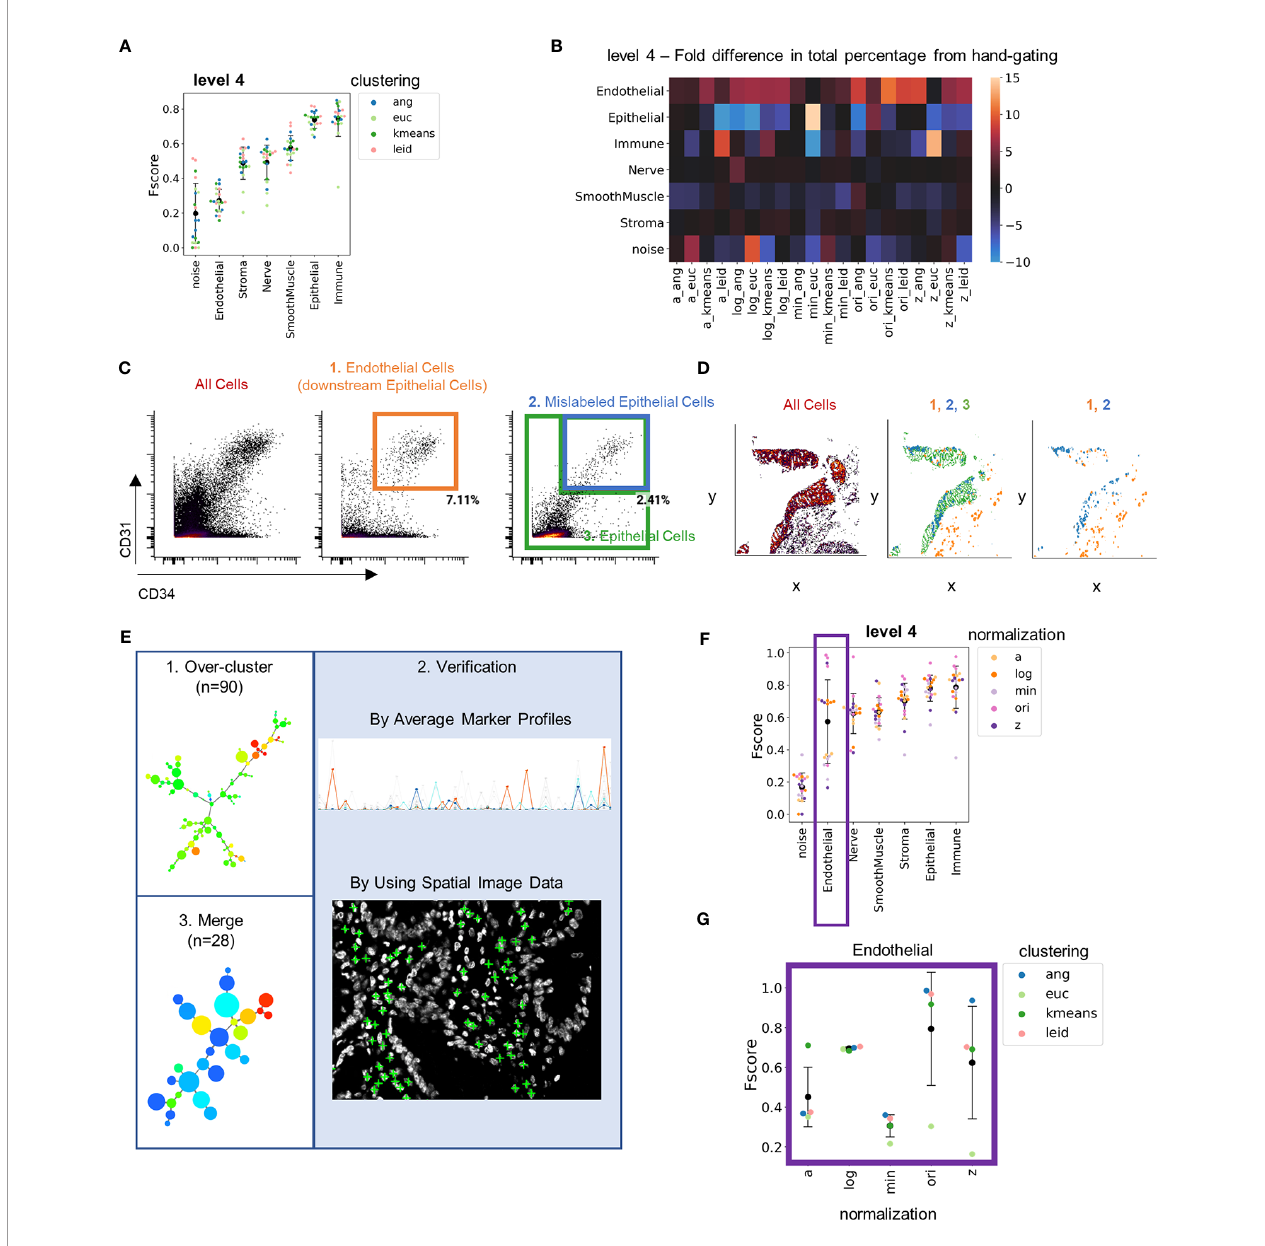
FIGURE 4 | Hand-gating is confounded by cell segmentation noise. (A) Level 4 F-score averaged across cell types for each combination of normalization technique and clustering algorithm as compared to hand-gating standard. (B) Heatmap of fold differences between cell-type percentages for level 4 for each combination of normalization technique and clustering algorithm as compared to hand gating annotations. (C) CD34 versus CD31 fl uorescent intensity (endothelial markers) for, from left to right, all cells, actual endothelial cells that are downstream of the Cytokeratin gate (orange box), and both mislabeled epithelial cells (blue) and all other epithelial cells (green). (D) Plots of, from left to right, all gated cells, three populations indicated by orange, green, and blue boxes in panel (C) , and just endothelial and mislabeled epithelial cells. (E) Overview of technique to generate an over-clustered standard dataset: 1) 90 clusters were generated by X-shift angular distance clustering with the original cell data, 2) clusters were annotated with cell type by evaluation of marker average pro fi les and location of cells withing tissue, and 3) common cell types were merged to a fi nal standard dataset of 28 clusters. (F) Level 4 F-scores averaged across cell types for each combination of normalization technique and clustering algorithm as compared to over-clustered standard. (G) Level 4 F-scores for the endothelial cell population for combinations of normalization and clustering techniques compared to the over-clustered standard (black data point is mean and error bars indicate standard